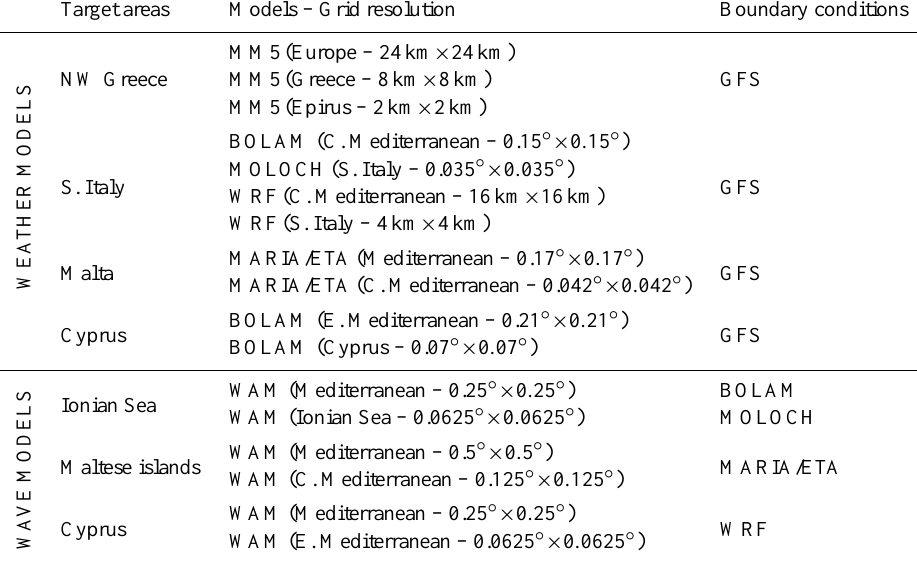
Table 1. Operational features of the implemented